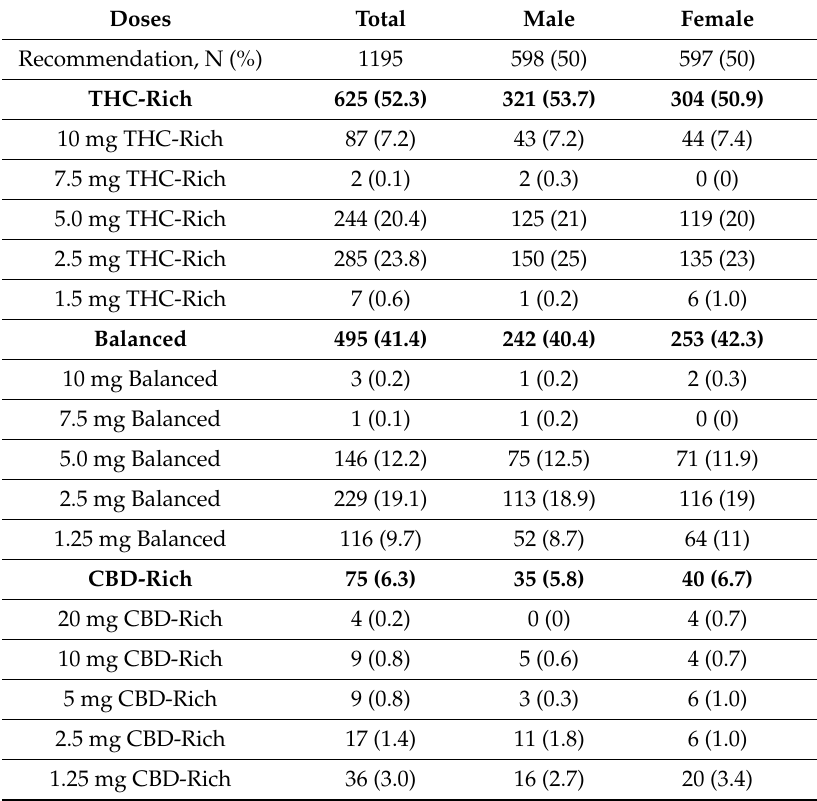
Comparison of MM recommendations for male and female patients in Louisiana MM